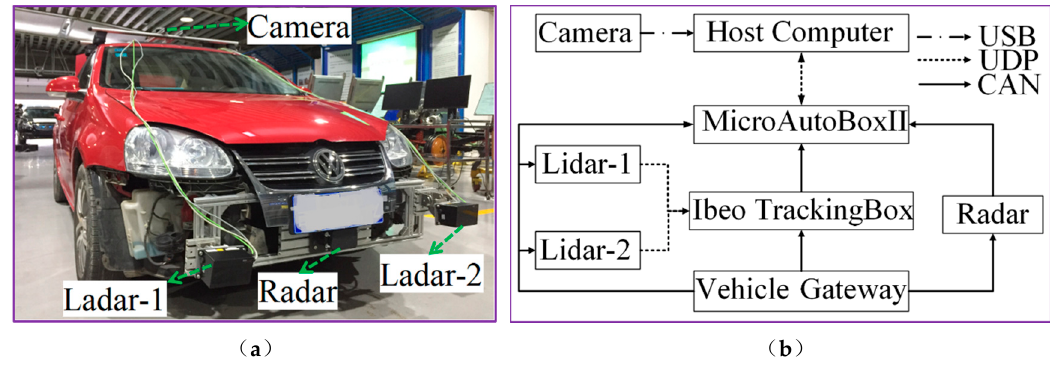
Figure 3. Experimental vehicle. (a) Test platform equipment, (b) experimental platform communication.